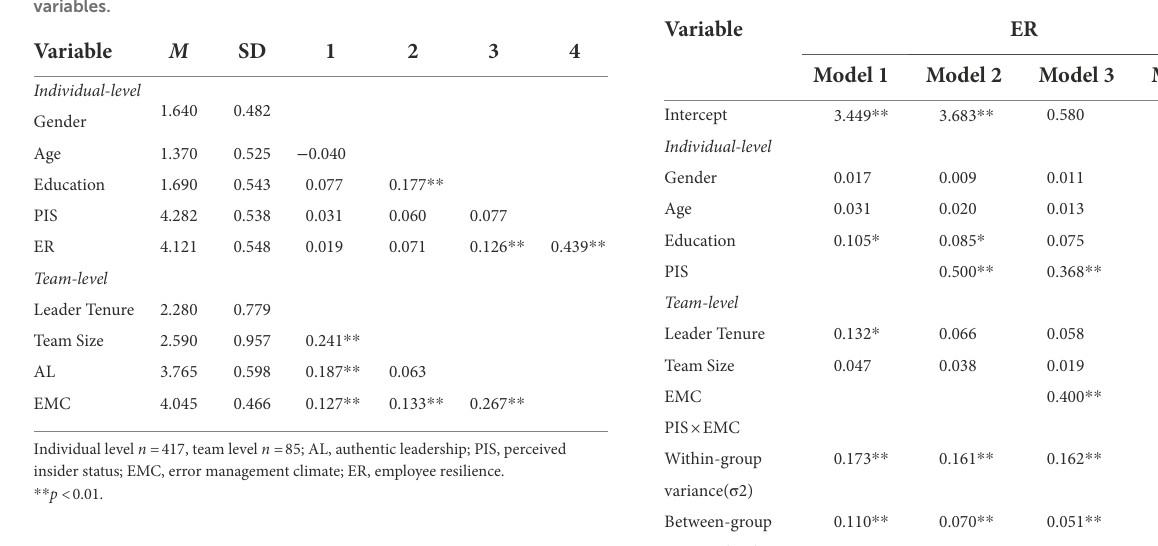
TABLE 4 The moderating effect analysis of